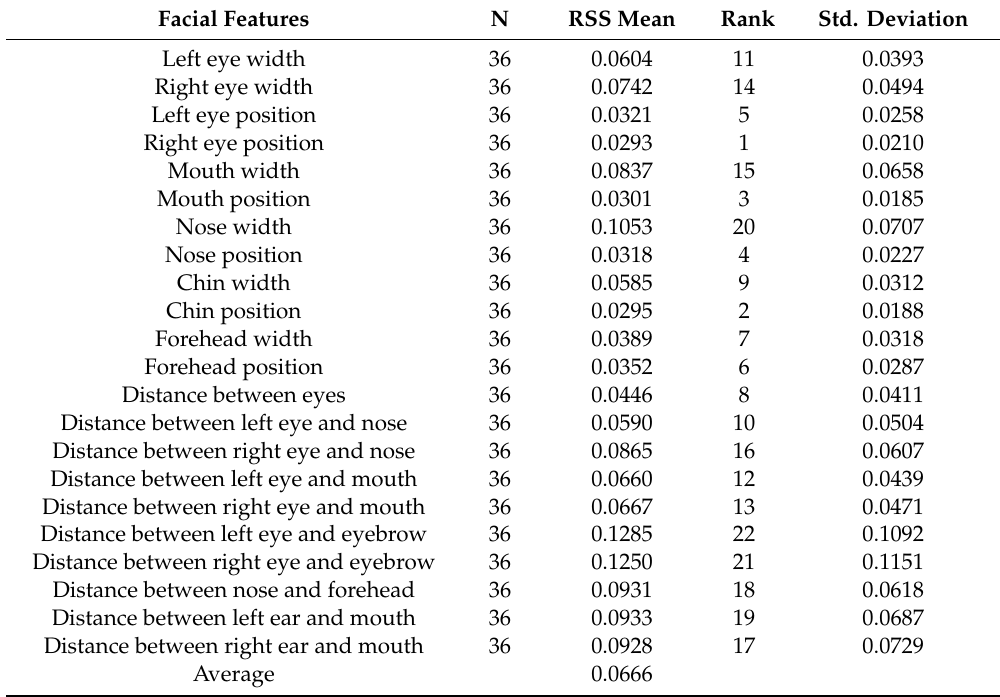
Table 8. The RSS means between fear expression and neutral mode of 22 facial features for 36